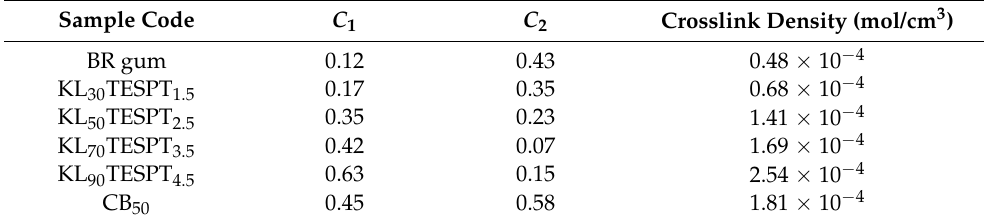
Table 3. Parameters obtained from the Mooney–Rivlin equation and calculated value of crosslink density of BR/kraft lignin/TESPT composites with various lignin content.